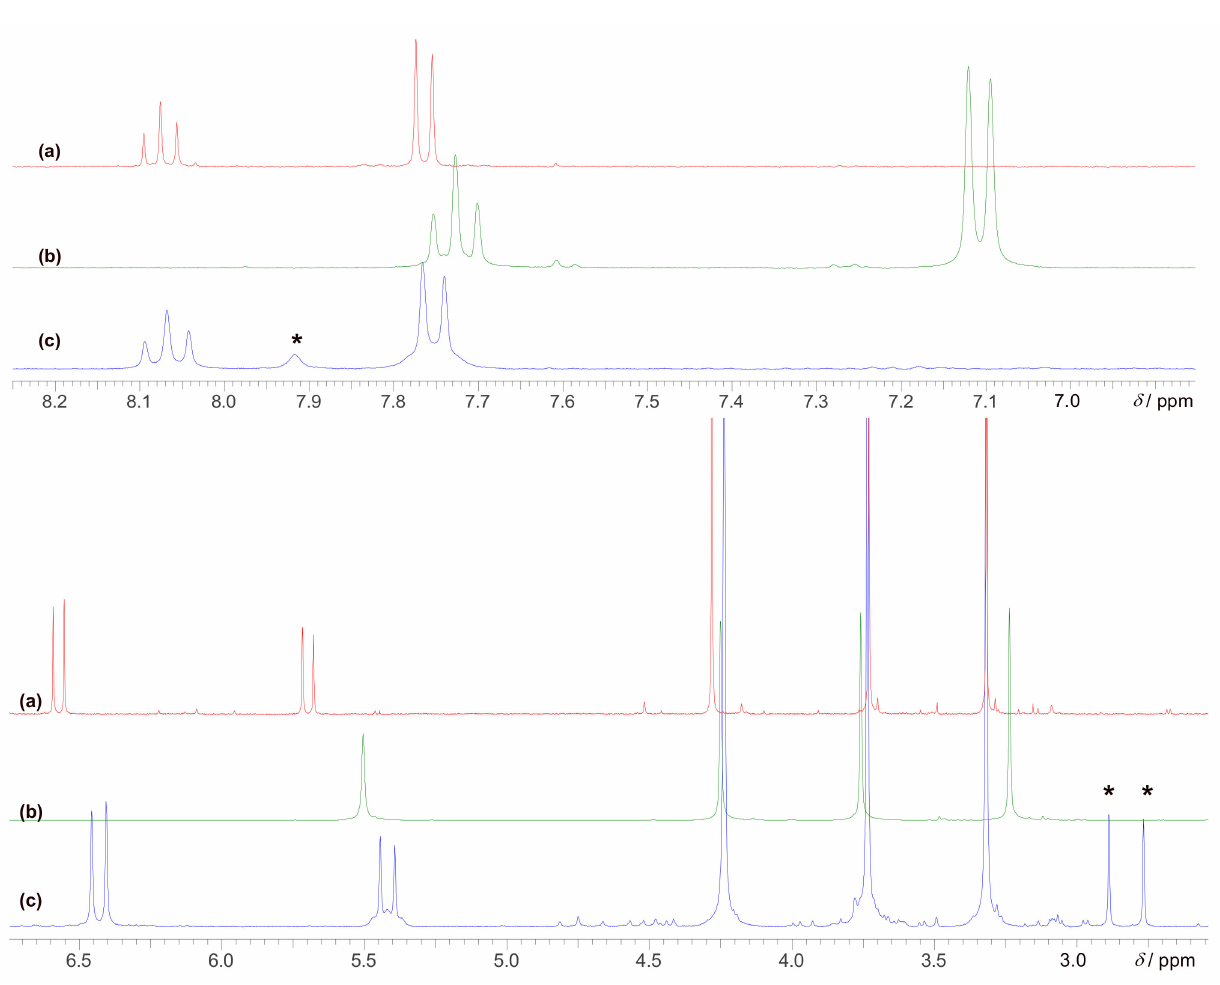
Figure 1. Stacked 1 H-NMR spectra allowing the comparison of complexes ( a ) 6 , ( b ) 5 and ( c ) 7 . Residual dimethylformamide is marked with an